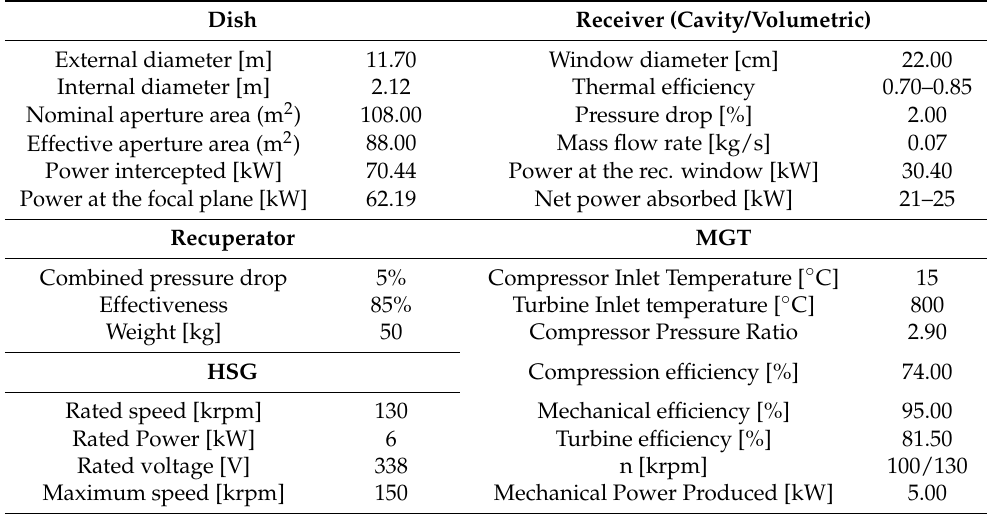
Table 1. Demo system nominal operating conditions and main component